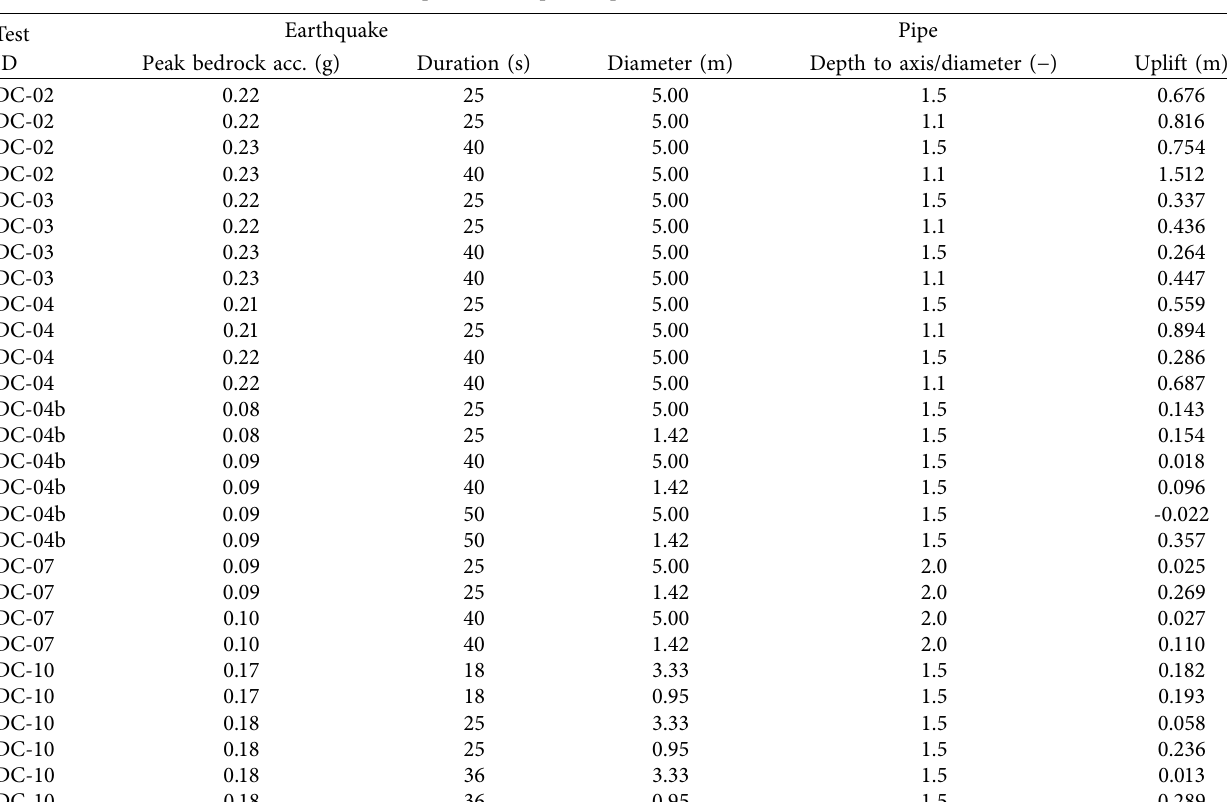
Table 3: Experimental uplift displacement (extracted from